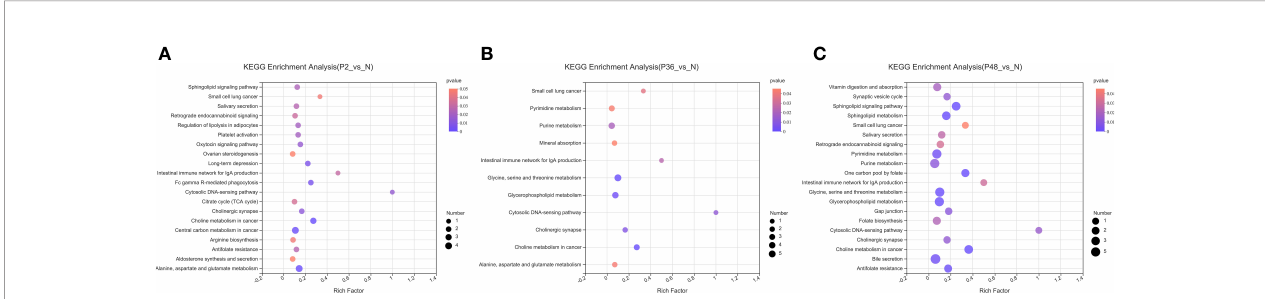
FIGURE 6 | KEGG pathway enrichment analysis of the hepatopancreas of Litopenaeus vannamei at different times after WSSV challenge. (A) KEGG pathways of P2 vs N. (B) KEGG pathways of P36 vs N. (C) KEGG pathways of P48 vs N. The abscissa of the bubble chart is the enrichment rate, and the ordinate is the KEGG pathway. The bubble size represents the amount of metabolites enriched in the metabolic concentration in the pathway. The bubble color indicates the size of the P value indicating enrichment signi fi